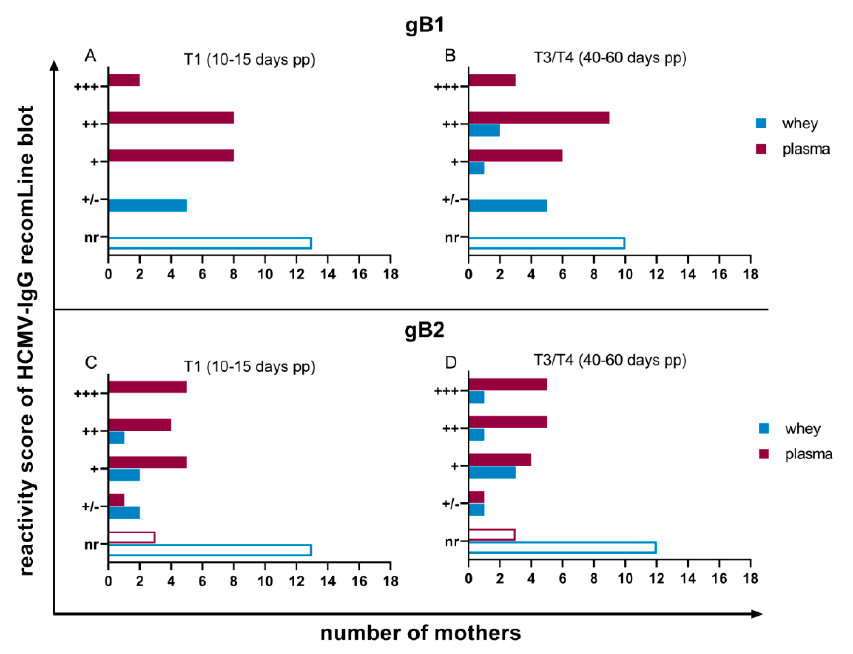
Figure 5. Reactivity scores of IgG recomLine blots for anti-recgB1-IgG at ( A ) T1 (10 to 15 days pp) and ( B ) T3/T4 (40 to 60 days pp) and anti-recgB2 at ( C ) T1 (10 to 15 days pp) and ( D ) T3/T4 (40 to 60 days pp). Scoring of antibody reactivity as in Figure 3.